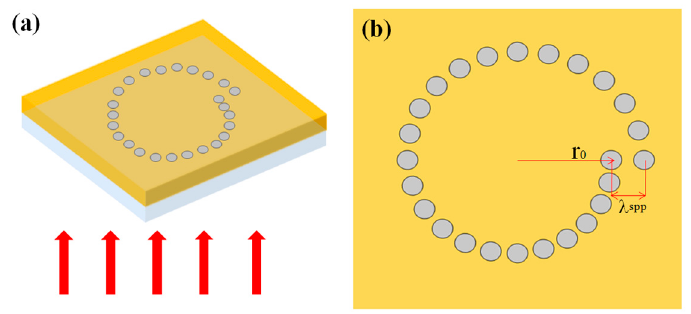
Figure 17. The schematic diagram of the single-turn Archimedean pinholes array (25 pinholes): lateral view ( a ) and the top view ( b ). Reproduced with permission from [63]. Copyright Optical Society of America, 2015.